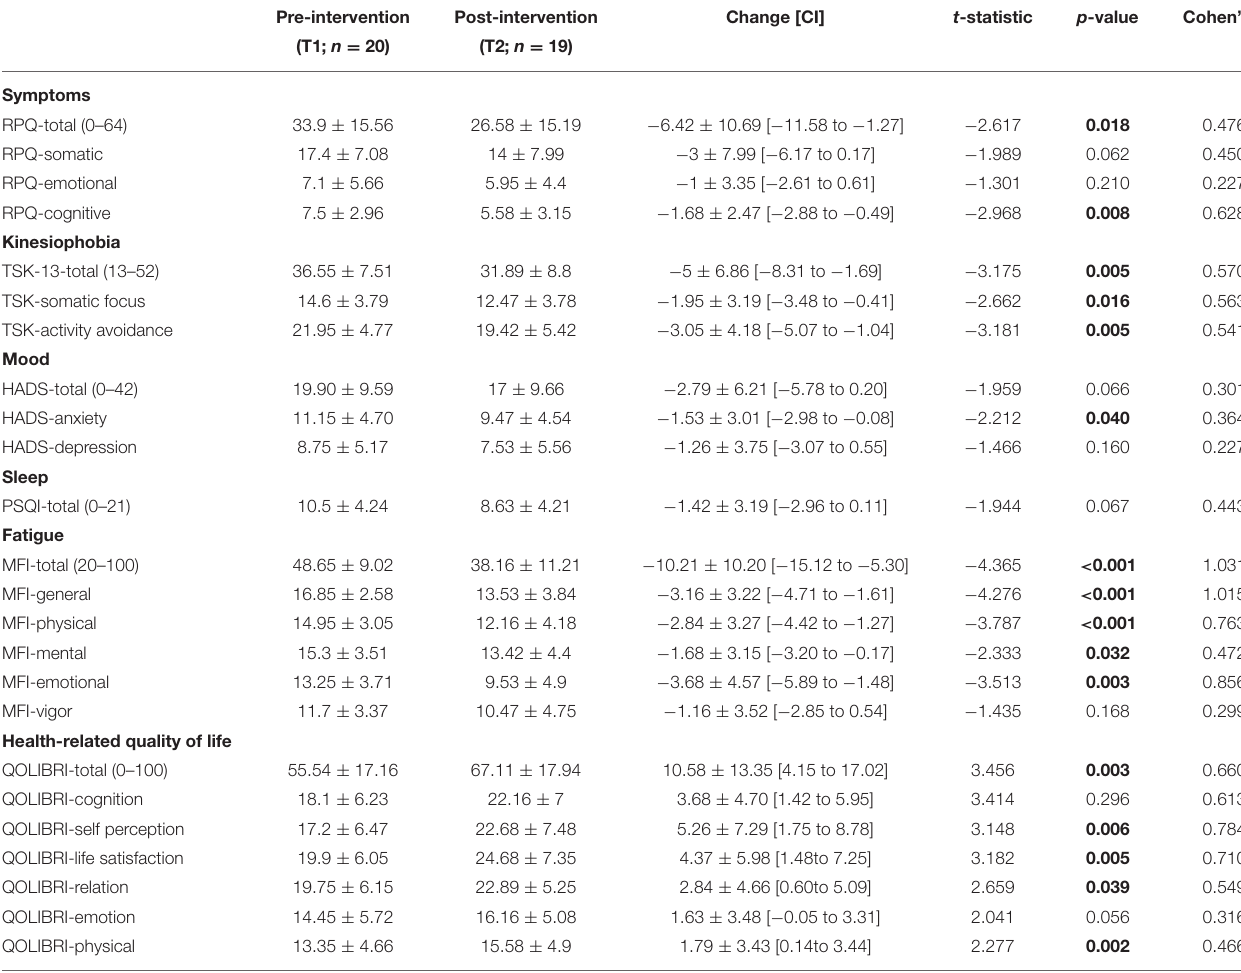
TABLE 5 | Descriptive statistics, paired sample t -test and effect size of post-concussion symptoms, kinesiophobia, mood, sleep, fatigue, and health-related quality of life exploratory health-related outcomes ( n =